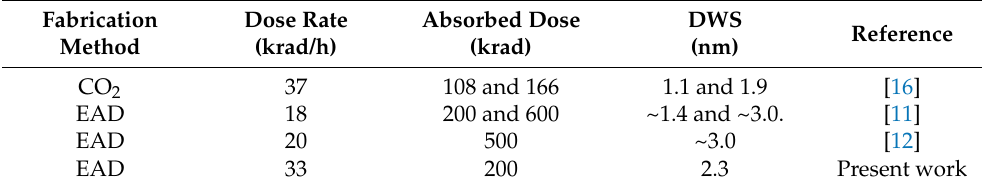
Figure 6. LPFG1 Dip Wavelength with Gamma radiation Dose (circles); LPFG1 data applying measurement time correction due to recovery of LPFG (squares) and data of the rad-hard FBGs (triangles). All the measurements were performed using the optical interrogator. Table 2. Comparison data of LPFGs inscribed in SMF-28 subjected to gamma radiation with present